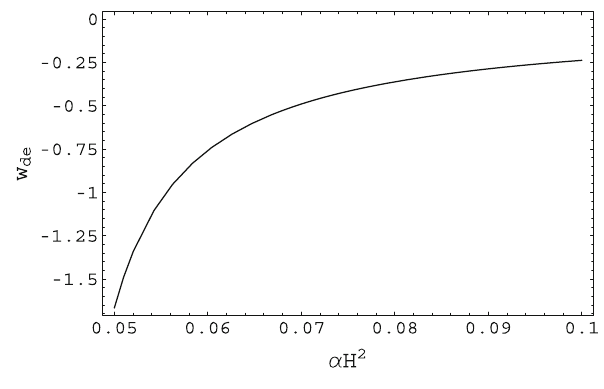
Fig. 1 The evolution of w de Table 1 The stability and eigenvalues of critical points for STG theory